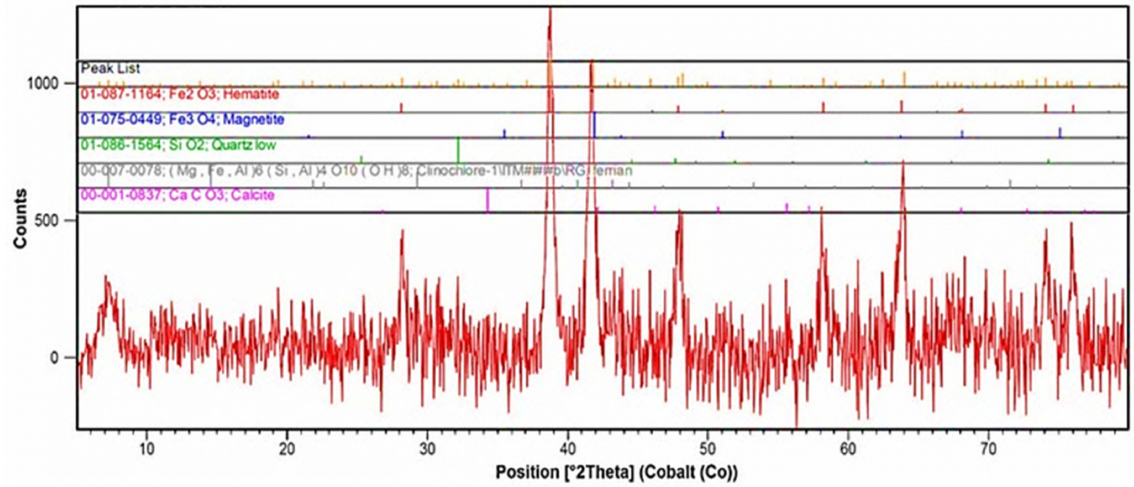
Figure 1. X-ray diffraction pattern of sample used in this